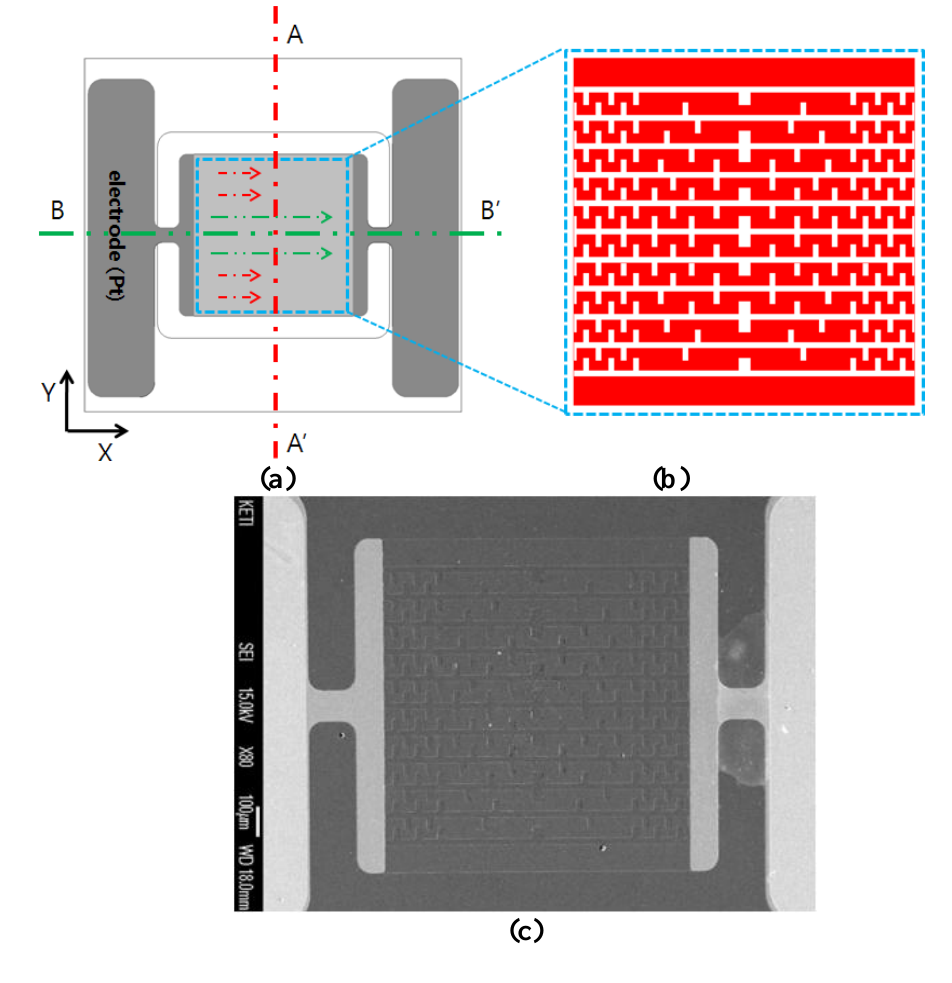
Figure 2. The power compensation structure of poly-Si film to enhance the temperature distribution. (a) current flow map in the micro-heater. (b) schematic drawing of compensation design of poly-Si film. (c) picture of compensation design in poly-Si